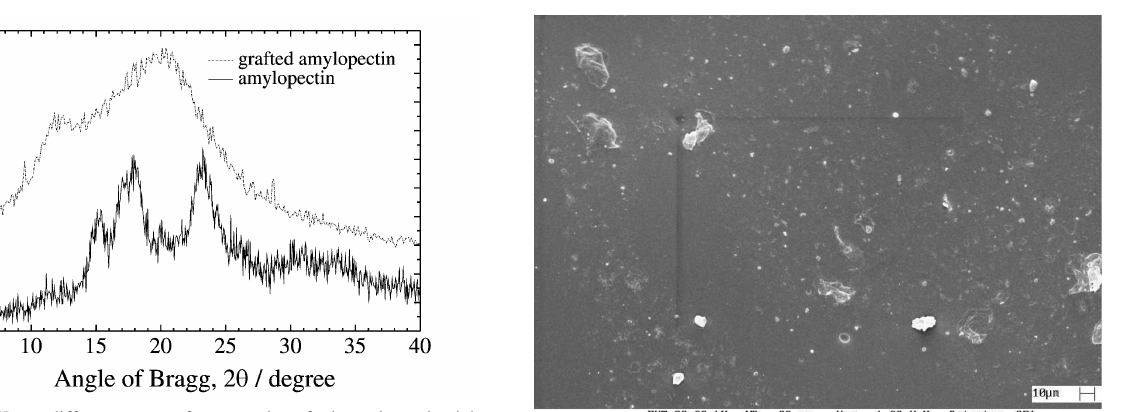
Figure 6. X-ray diffractograms of pure and grafted amylopectin-rich stanch.